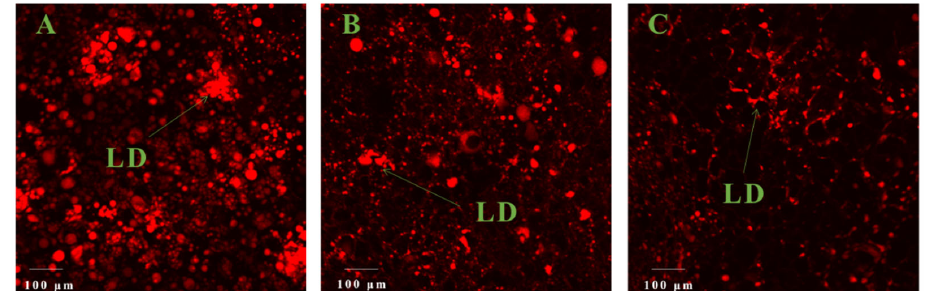
Figure 1. Confocal microscopy images of lipid droplets in the mature mesocarps of three avocado ecotypes. ( A ) Mexican ecotype (Walter Hole); ( B ) Guatemalan ecotype (Nabal); ( C ) West Indian ecotype (Donnie). Lipid droplets were visualized by Nile red staining. LD: lipid droplet.